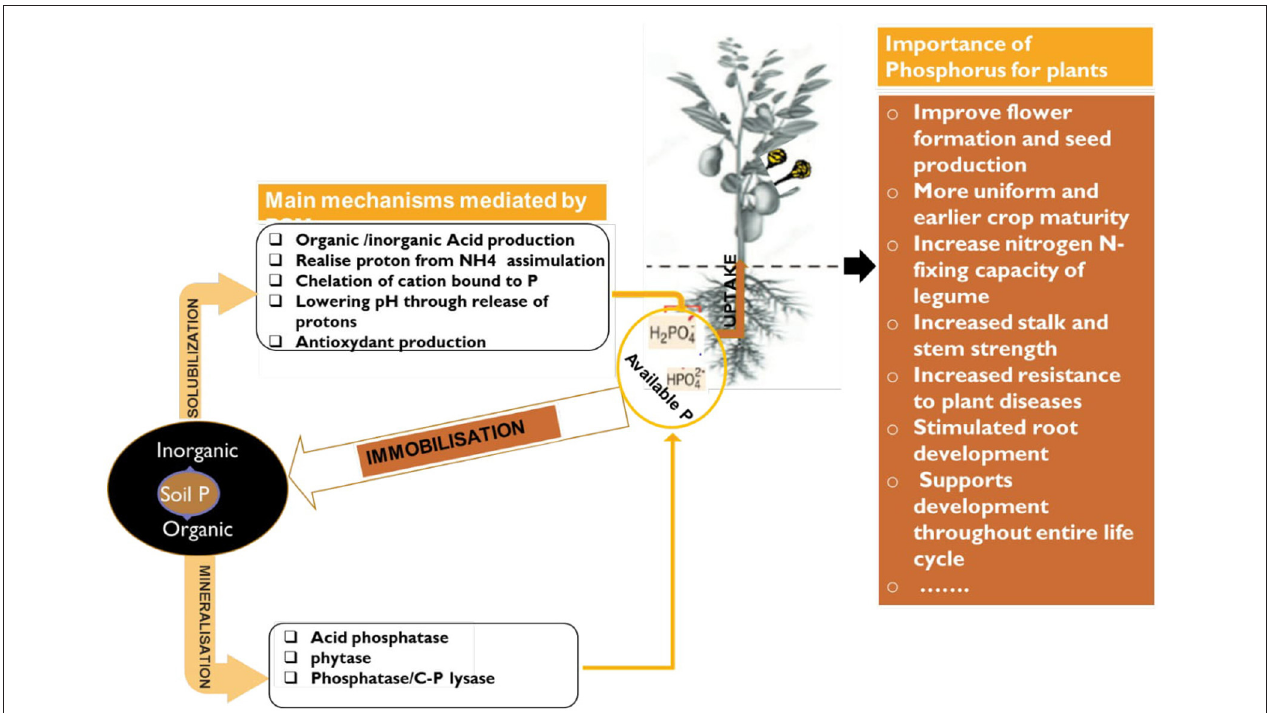
FIGURE 4 | Schematic representation of P solubilization/mineralization/immobilization by PSM and its importance for plant